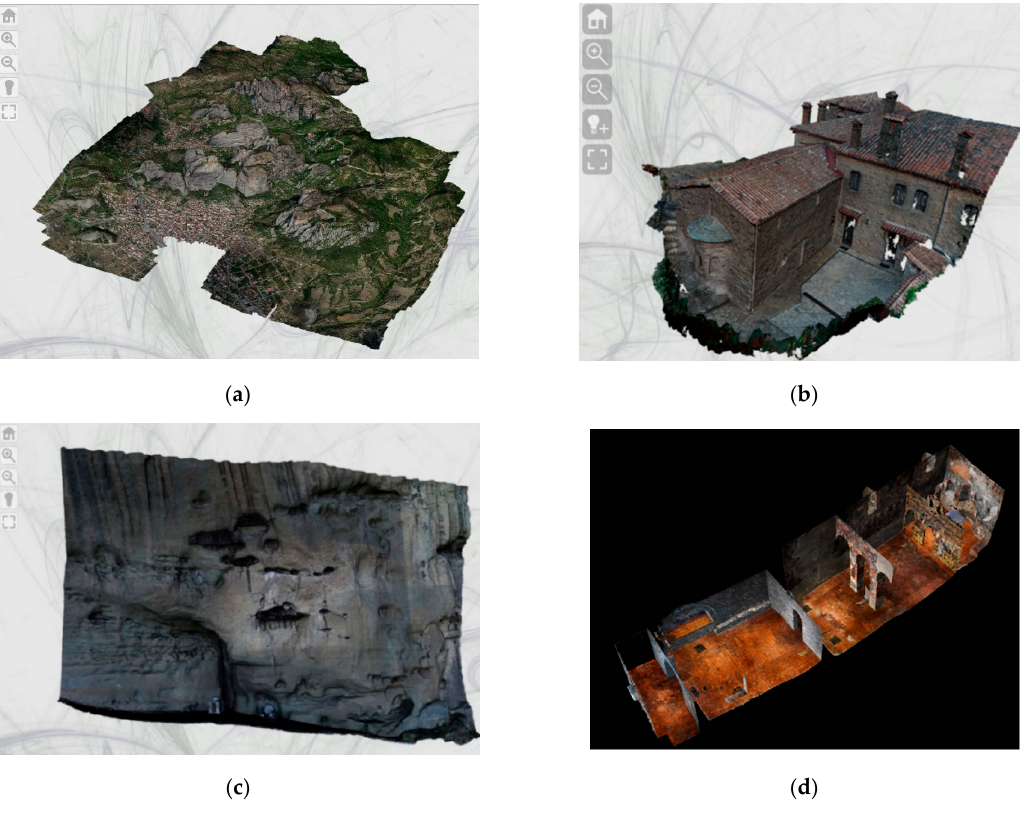
Figure 6. The 3D inputs of the developed platform in the 3DHOP’s basic user interface ( a ) 3D model of the archaeological site of Meteora ( b ) 3D model of the exterior of St. Stephen’s old catholikon ( c ) 3D model of Pixari rock ( d ) 3D model of the interior of St. Stephen’s old catholikon.